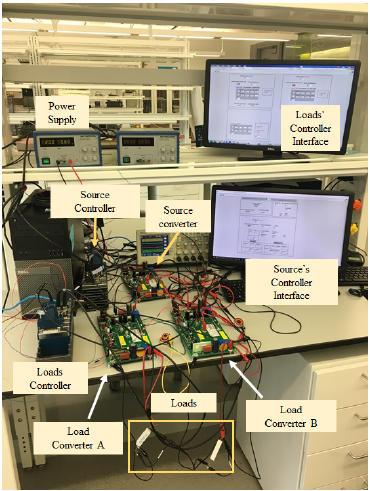
Figure 14. The experimental setup.